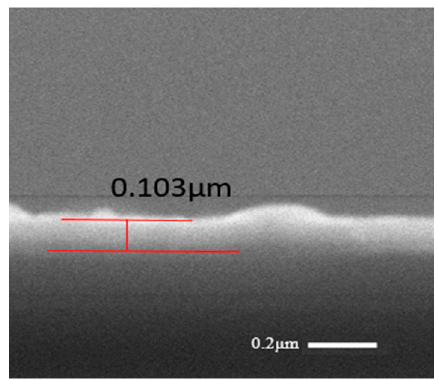
Figure 9. Scanning electron microscope (SEM) image of InGaZnO.